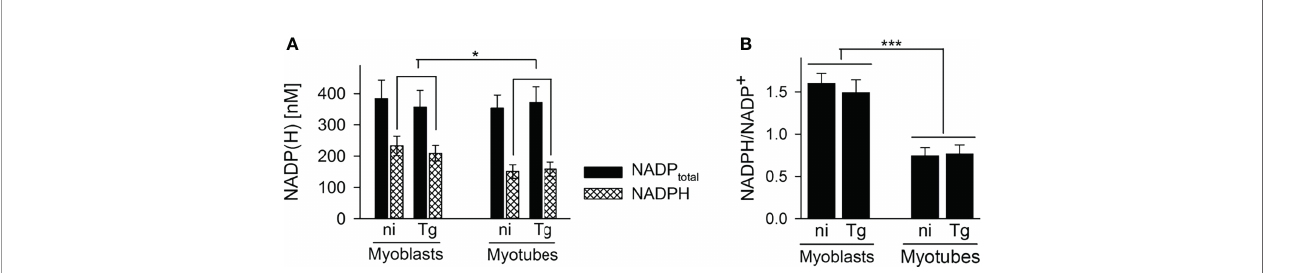
FIGURE 4 | Myoblasts contain more NADPH during infection with T. gondii . C2C12 myoblasts and in vitro -differentiated myotubes were infected with T. gondii or were left non-infected. After cell extraction at 48 hours of infection, total NADP (i.e. NADP + and NADPH) and NADPH levels were determined using a colorimetric assay and standards of known concentrations. Bars in (A) represent mean concentrations ± S.E.M. of total NADP (black bars) and NADPH (cross-hatched bars) from non-infected (ni) and T. gondii -infected (Tg) cells as indicated. Bars in (B) represent the mean ratios ± S.E.M. of NADPH to NADP + (i.e. total NADP minus NADPH) from four independent experiments. Signi fi cant differences were identi fi ed by ANOVA (* p < 0.05; *** p